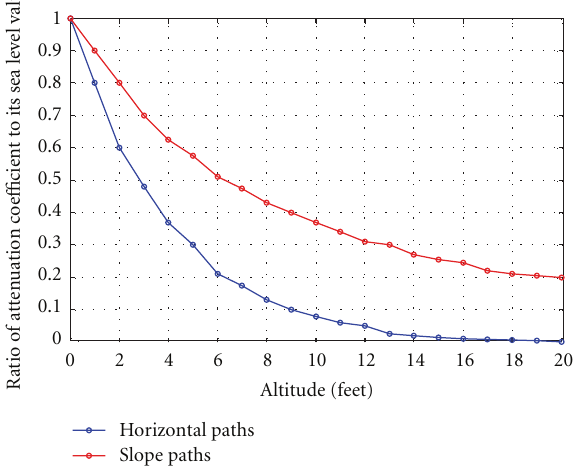
Figure 10: Altitude E ff ects on atmospheric attenuation coe ffi cient.